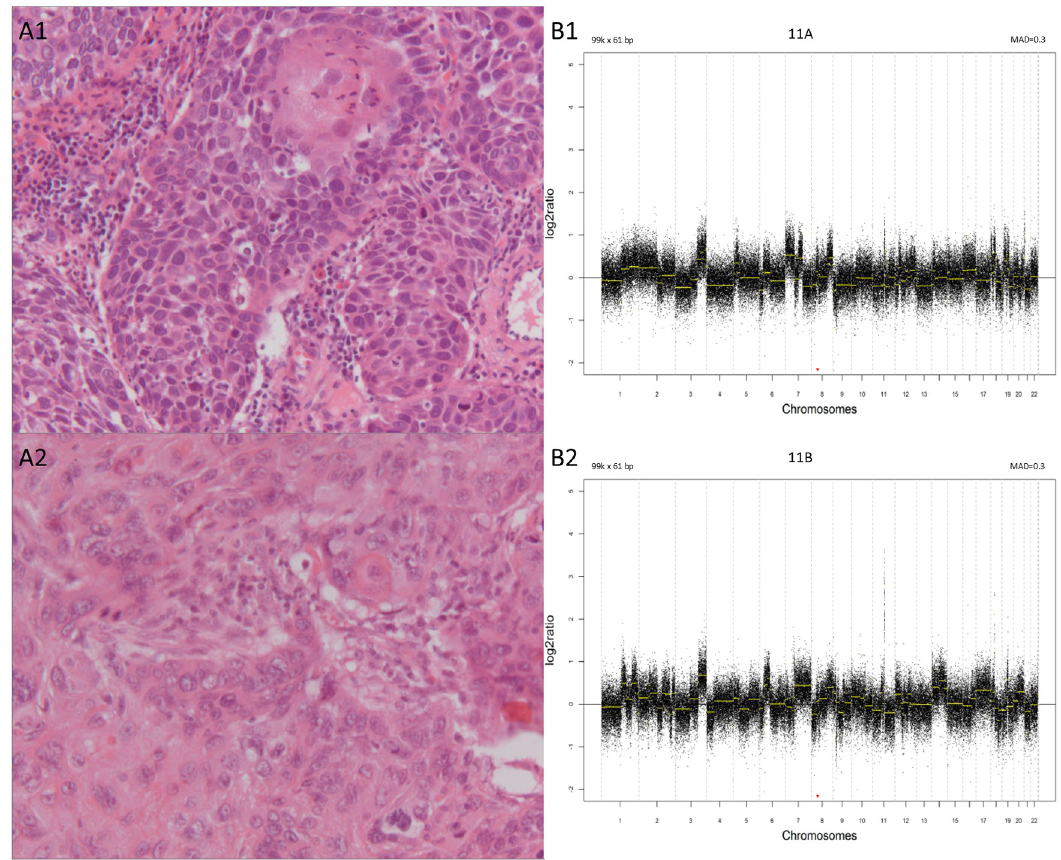
Fig 1. Example of a matching histologic pair with a non-clonal CNA-result. A1 & A2: squamous cell carcinomas from a laryngeal tumor biopsy and a resected tumor in the left lower lobe, respectively (20x objective). B1 & B2: the corresponding CNA profiles. On the y axis is the log2 tumor to normal ratio and on the x axis the chromosomal position. MAD = median absolute